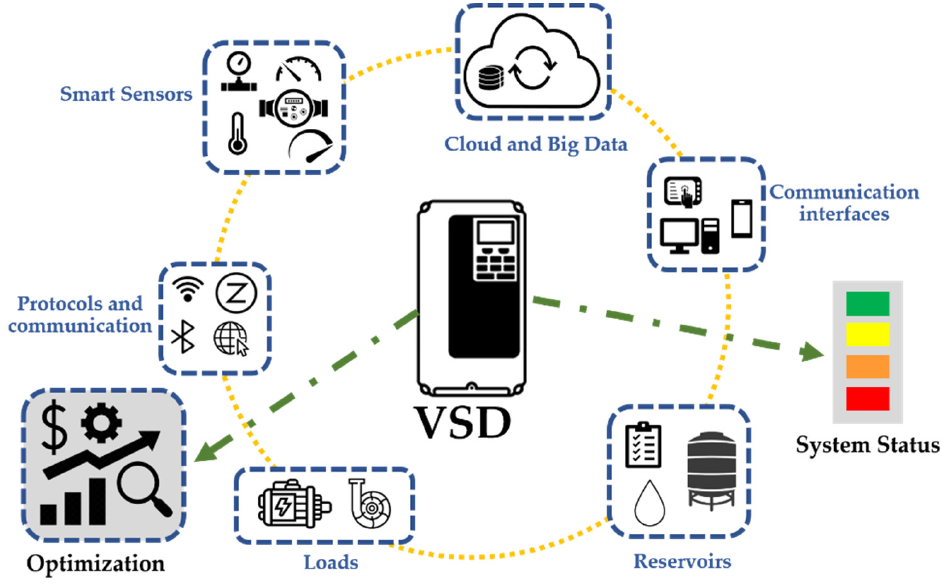
Figure 7. VSD is a core element of Smart Pumping.